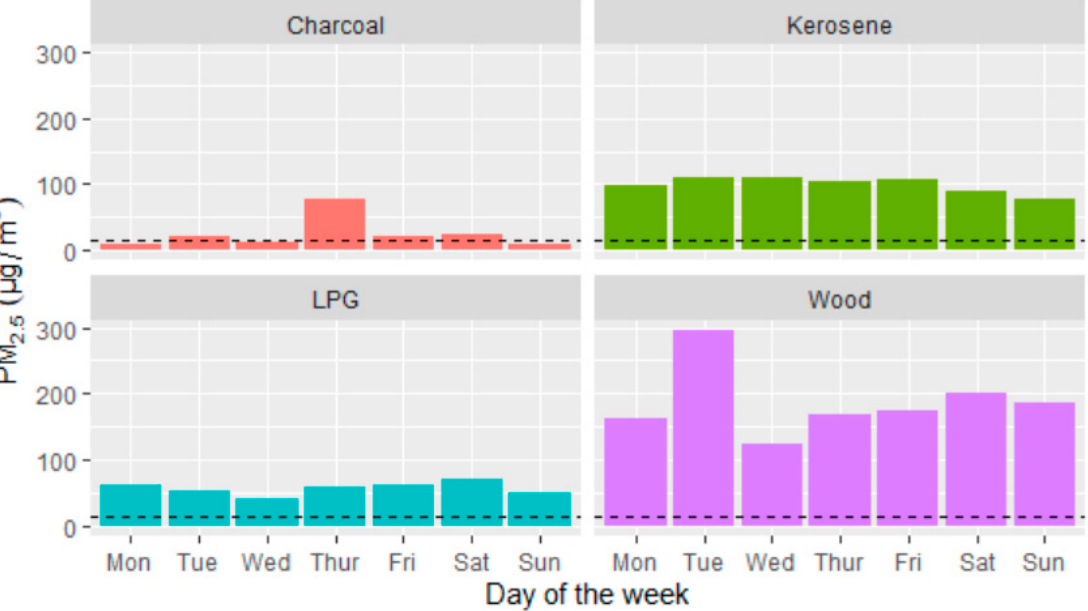
Figure 5. Graph showing daily variation of PM 2.5 by fuel type. Dotted line plotted at 15 µg/m 3 , which is the mean 24 h WHO limit.